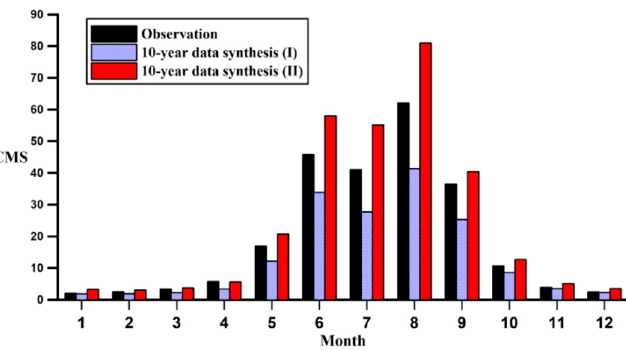
Figure 14. Comparisons of 10-year flow data.